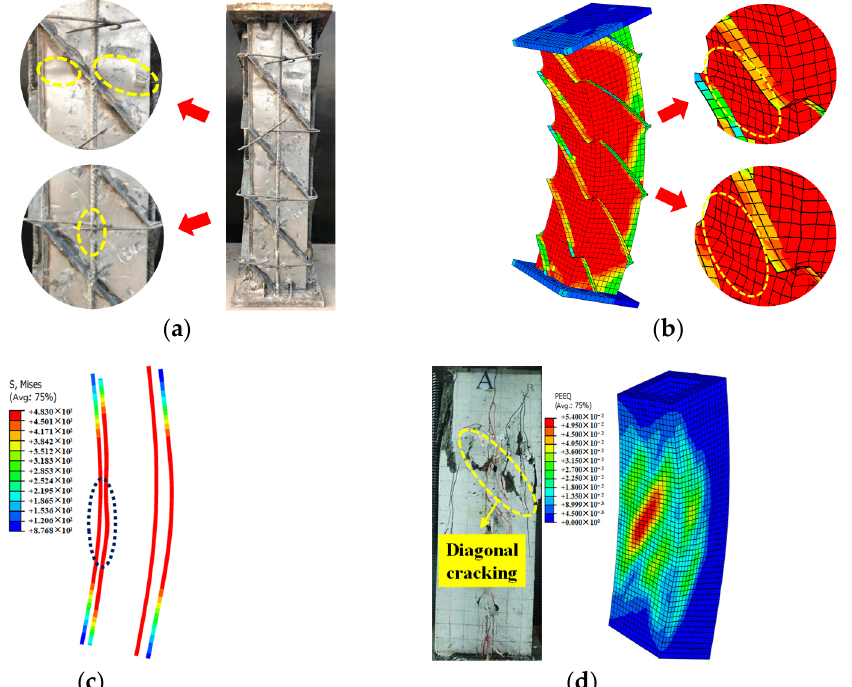
Figure 17. Finite element model loading and test comparison of specimen Z3. ( a ) Steel pipe and steel bar test phenomenon; ( b ) Buckling simulation of a spirally ribbed steel pipe; ( c ) Buckling simulation of steel bar; ( d ) Concrete failure simulation.